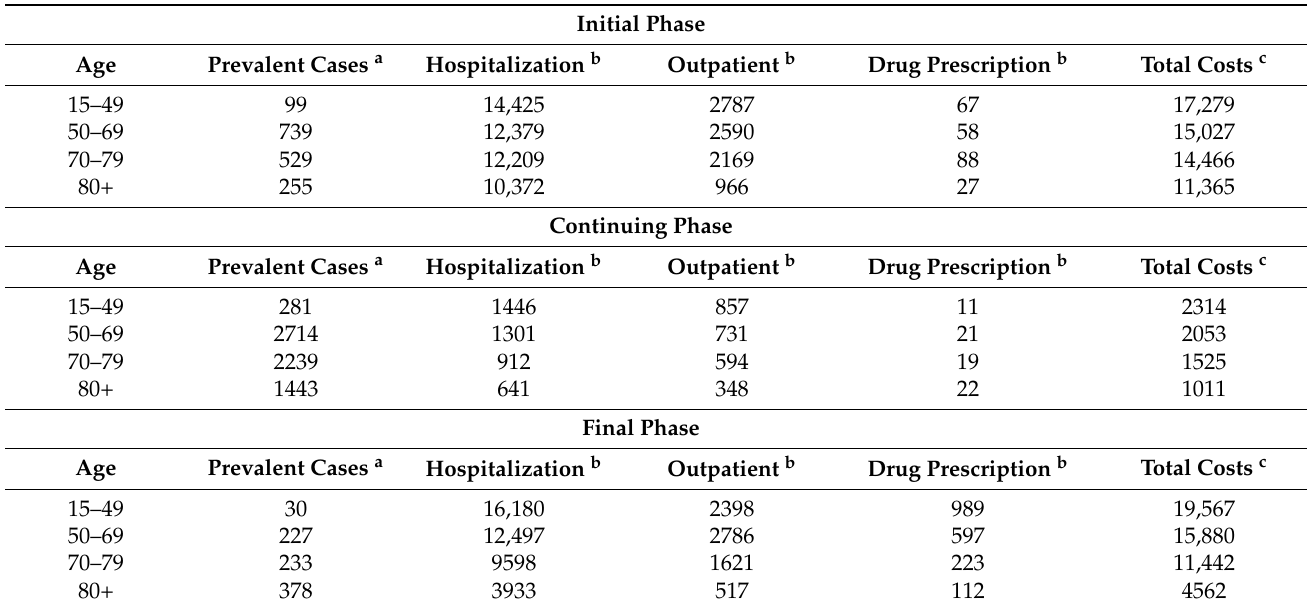
Table 2. Prevalent cases by age at prevalence and patient annual average costs by age at prevalence, phase of care and type of service. Pool of